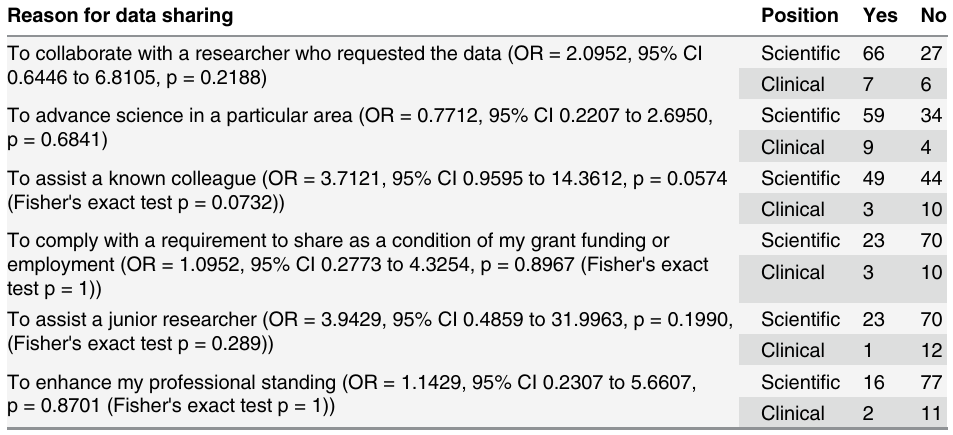
Table 10. Odds ratio results for differences between scientific and clinical researchers regarding rea- sons for sharing. Reason for data sharing